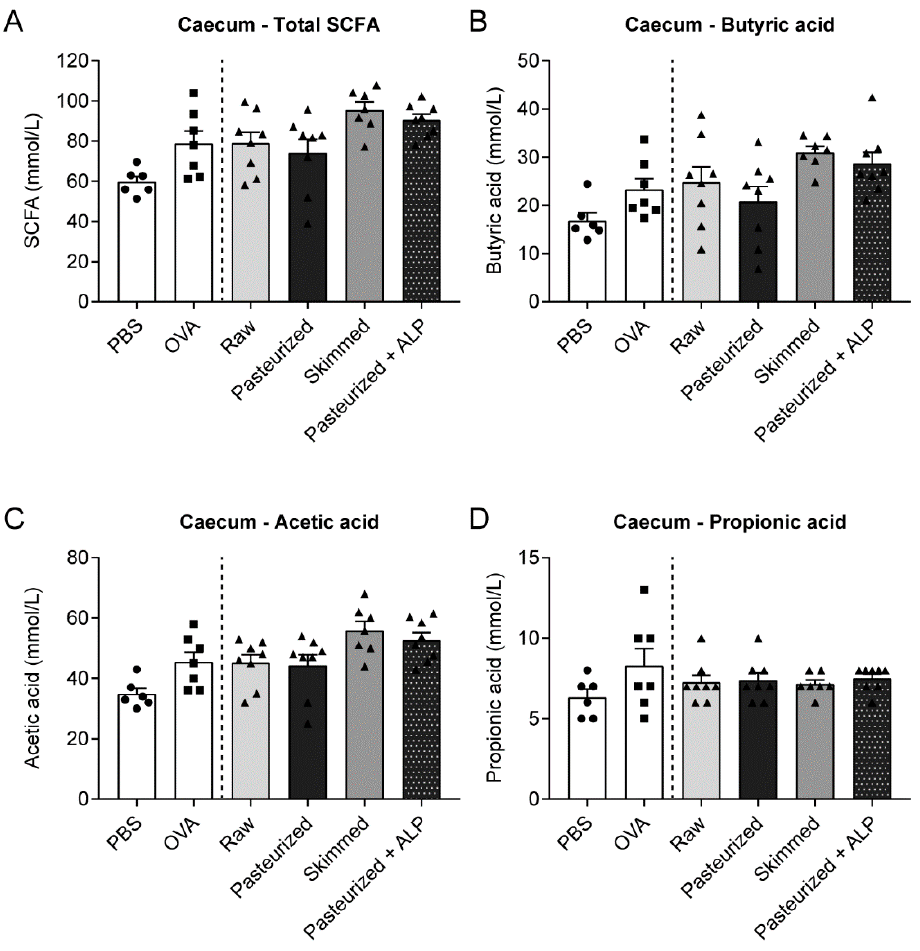
Figure 6. No differences in SCFA concentrations between milk groups. ( A ) Total SCFA concentrations and individual concentrations of ( B ) butyric acid, ( C ) acetic acid and ( D ) propionic acid measured in caecal content. Data are presented as mean ± SEM, including individual data points, n = 6 in PBS group and n = 7–8 in all other groups. No significant differences were observed. SCFA, short-chain fatty acids; PBS, phosphate-buffered saline; OVA, ovalbumin; raw, raw cow’s milk; pasteurized, pasteurized cow’s milk; skimmed, skimmed raw cow’s milk; pasteurized + ALP, pasteurized milk spiked with alkaline phosphatase.